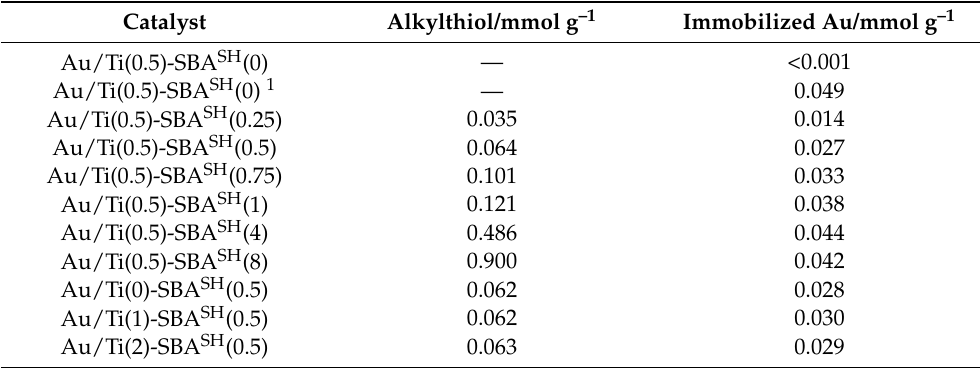
Au/Ti(0.5)-SBA SH (0) — <0.001